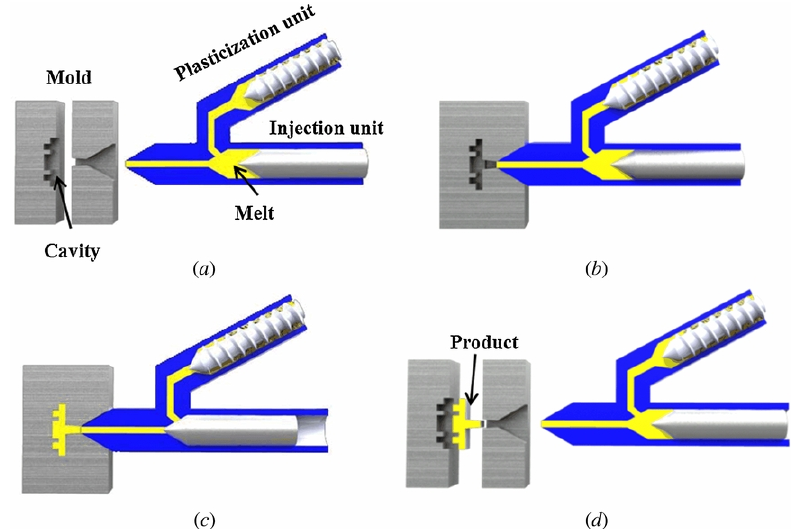
Figure 3. μ IM process demonstration with separate plasticization and injection units: ( a ) plasticiza- tion, ( b ) mold closing, ( c ) injection, packing and cooling, and ( d ) demolding and re-plasticization for the next cycle. Adapted, with permission, from [56]. 2013, IOPscience.